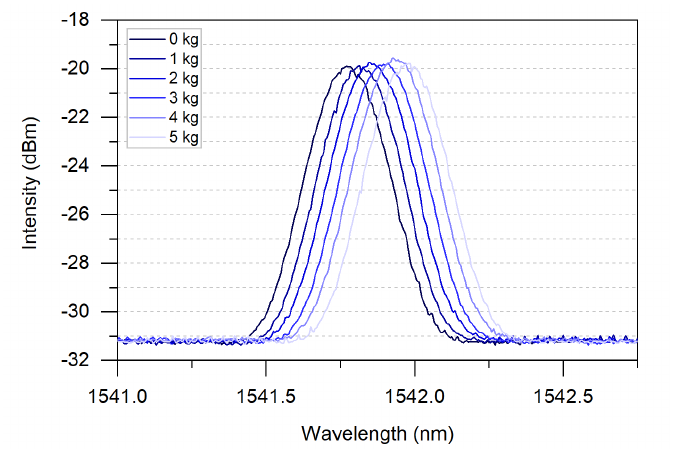
Figure 7. FBG reflected peak during loadings